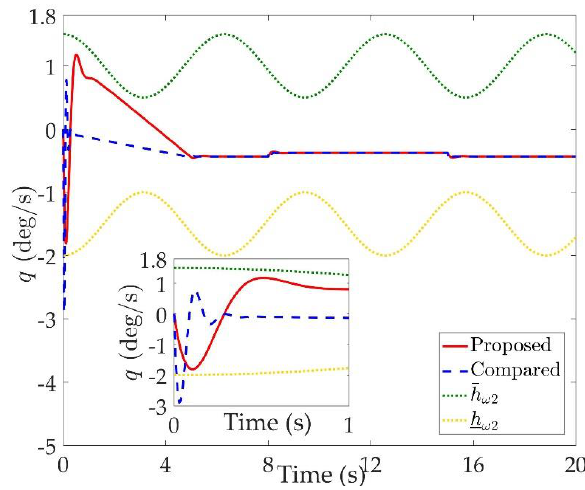
Sensors 2020 , 20 , 848 Figure 6. Comparison curves of the pitch rate <!-- MathType@Translator@5@5@MathML2 (no Figure 6. Comparison curves of the pitch rate q .